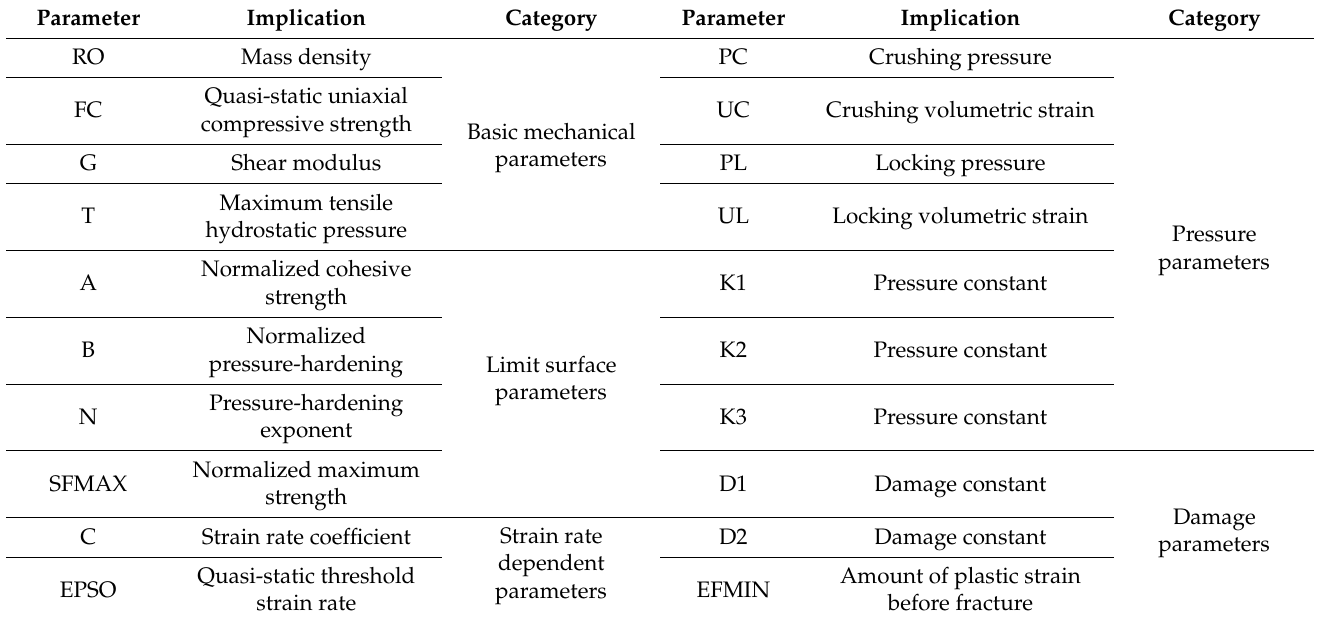
Table 1. Classification of HJC model parameters.